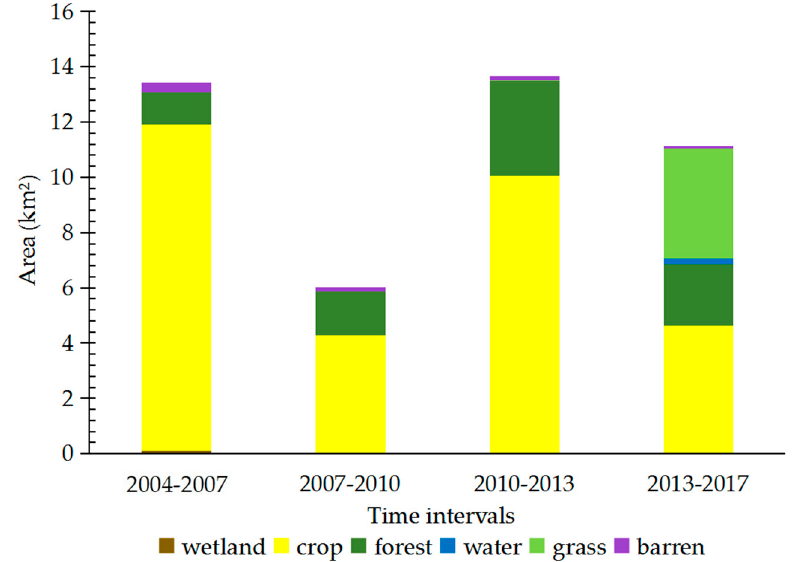
Figure 9. Statistics of urban expansion from other land cover types from 2004 to 2017.